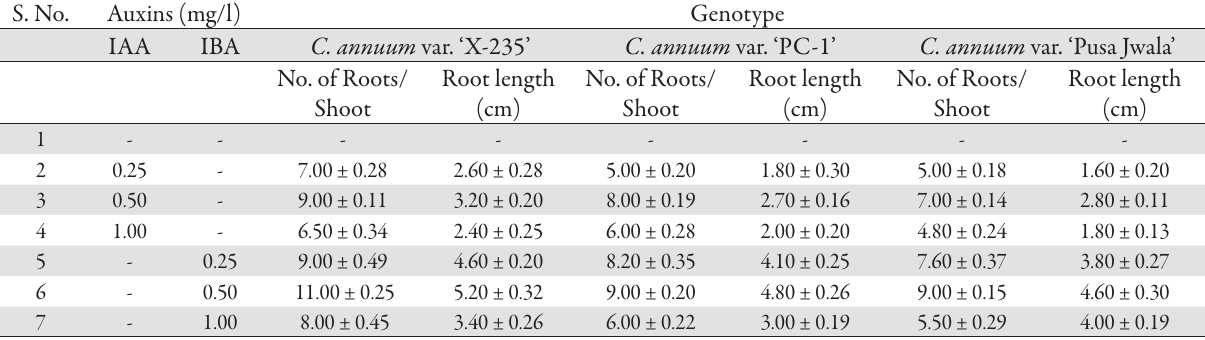
Tab. 2. Effect of Auxins on rooting of in vitro induced shoot buds from hypocotyl explants of three genotypes of C. annuum L. S.